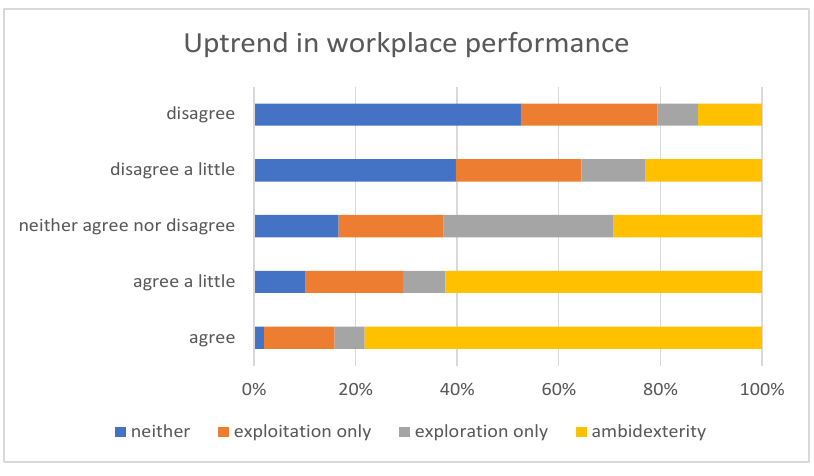
Figure 1. Relationship between organizational ambidexterity and workplace